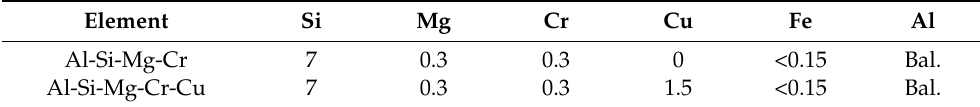
Table 1. Chemical composition of Al alloy specimens (wt.%).